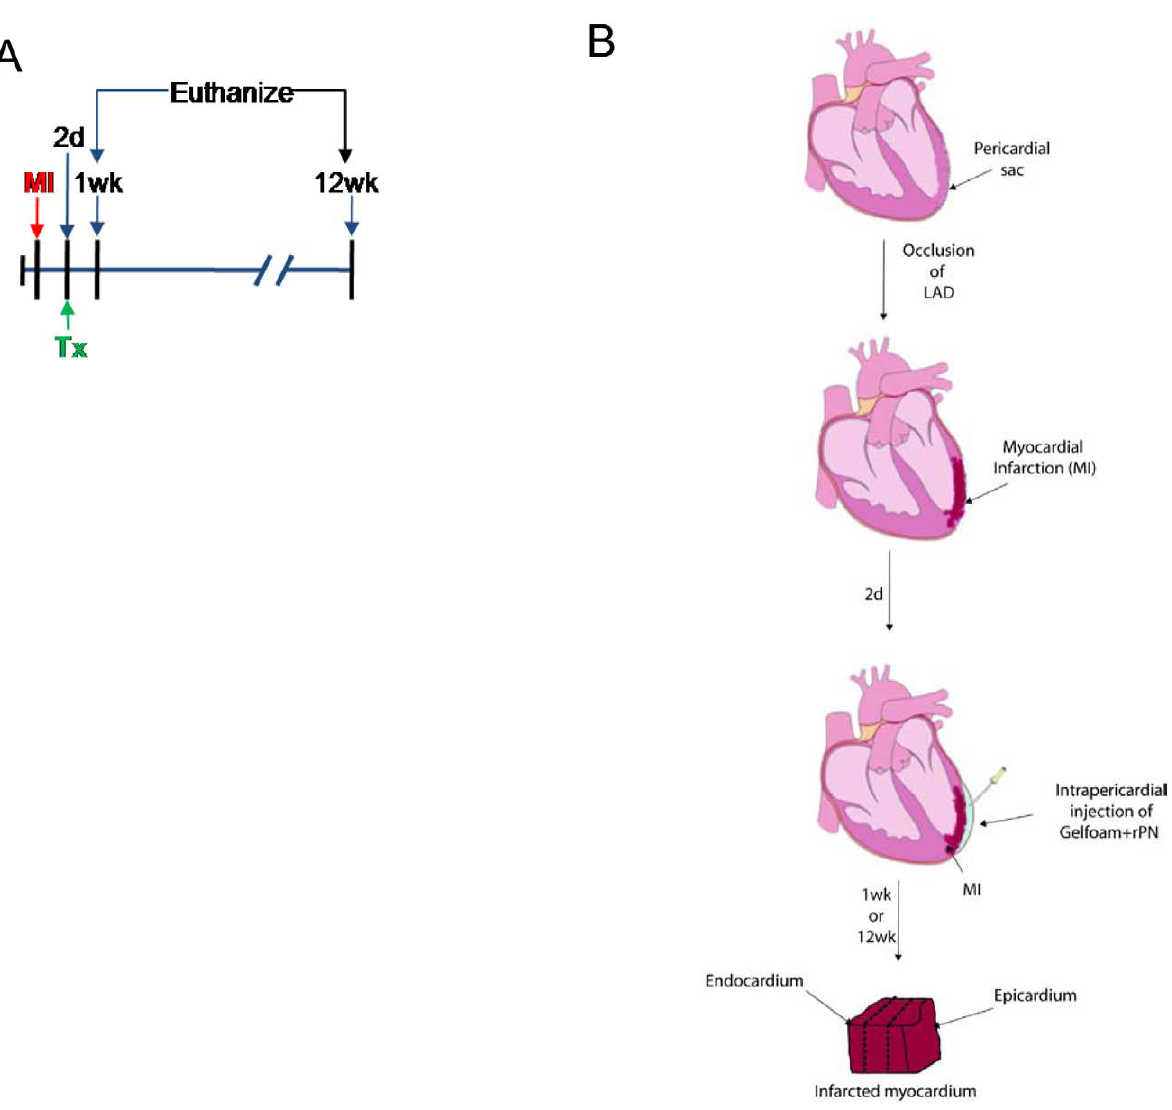
Figure 4. Myocardial infarction timeline and strategy for targeted delivery. (A) Experimental design for the delivery of rPN in a swine model of myocardial infarction (MI). (B) Schematic illustration of the intrapericardial delivery of Gelfoam/rPN system and our strategy for tissue collection.